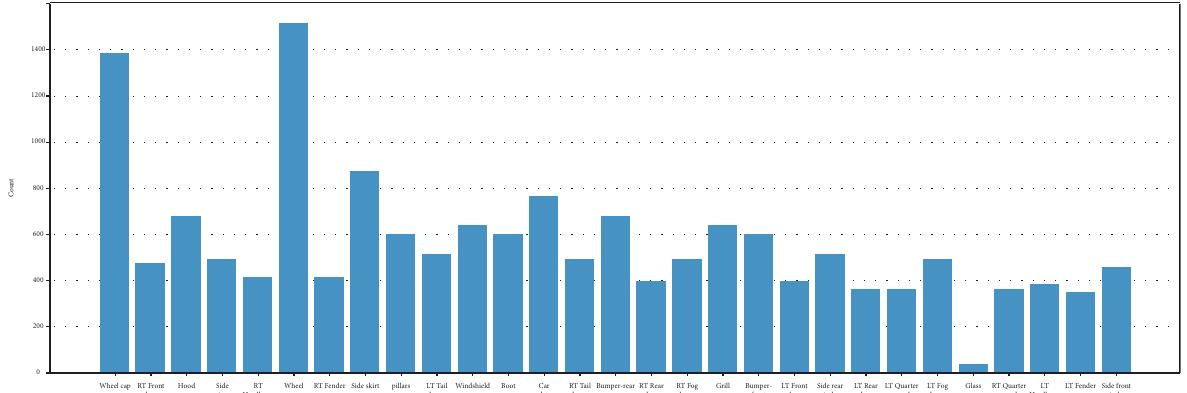
Figure 7: Distribution of various car part types in the dataset, including 29 diferent classes.